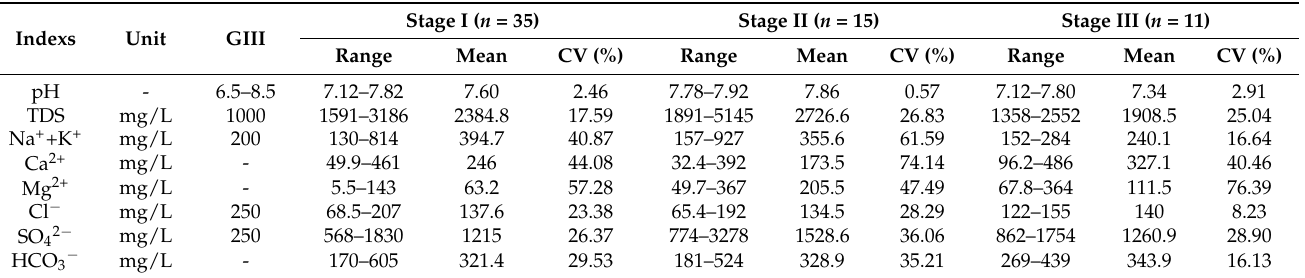
Table 2. Statistical table of conventional component content of karst groundwater in Taiyuan